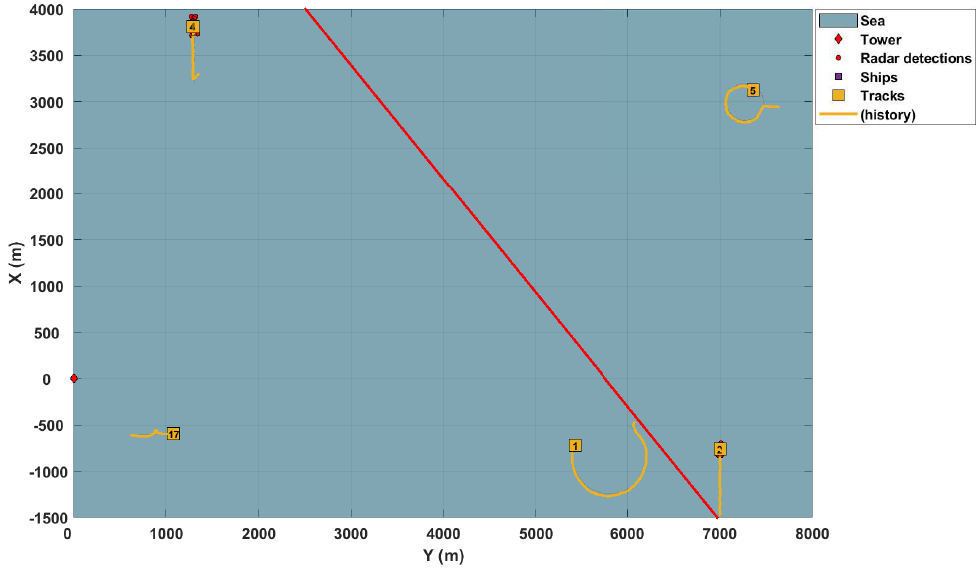
Figure 8. Complete tracking with merged